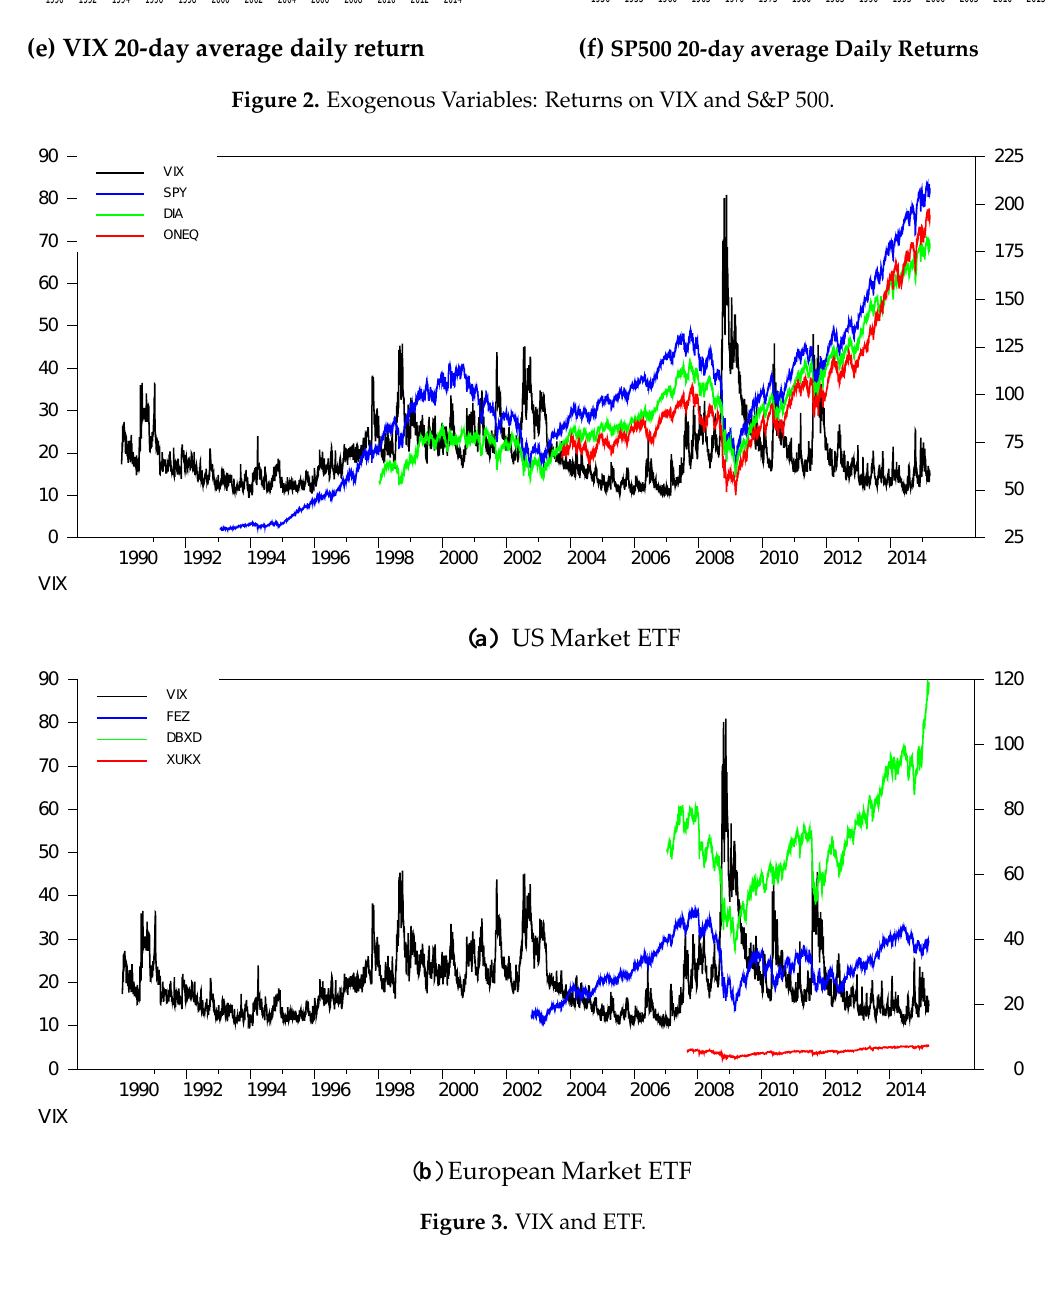
Figure 3. VIX and ETF. Figure 3. VIX and